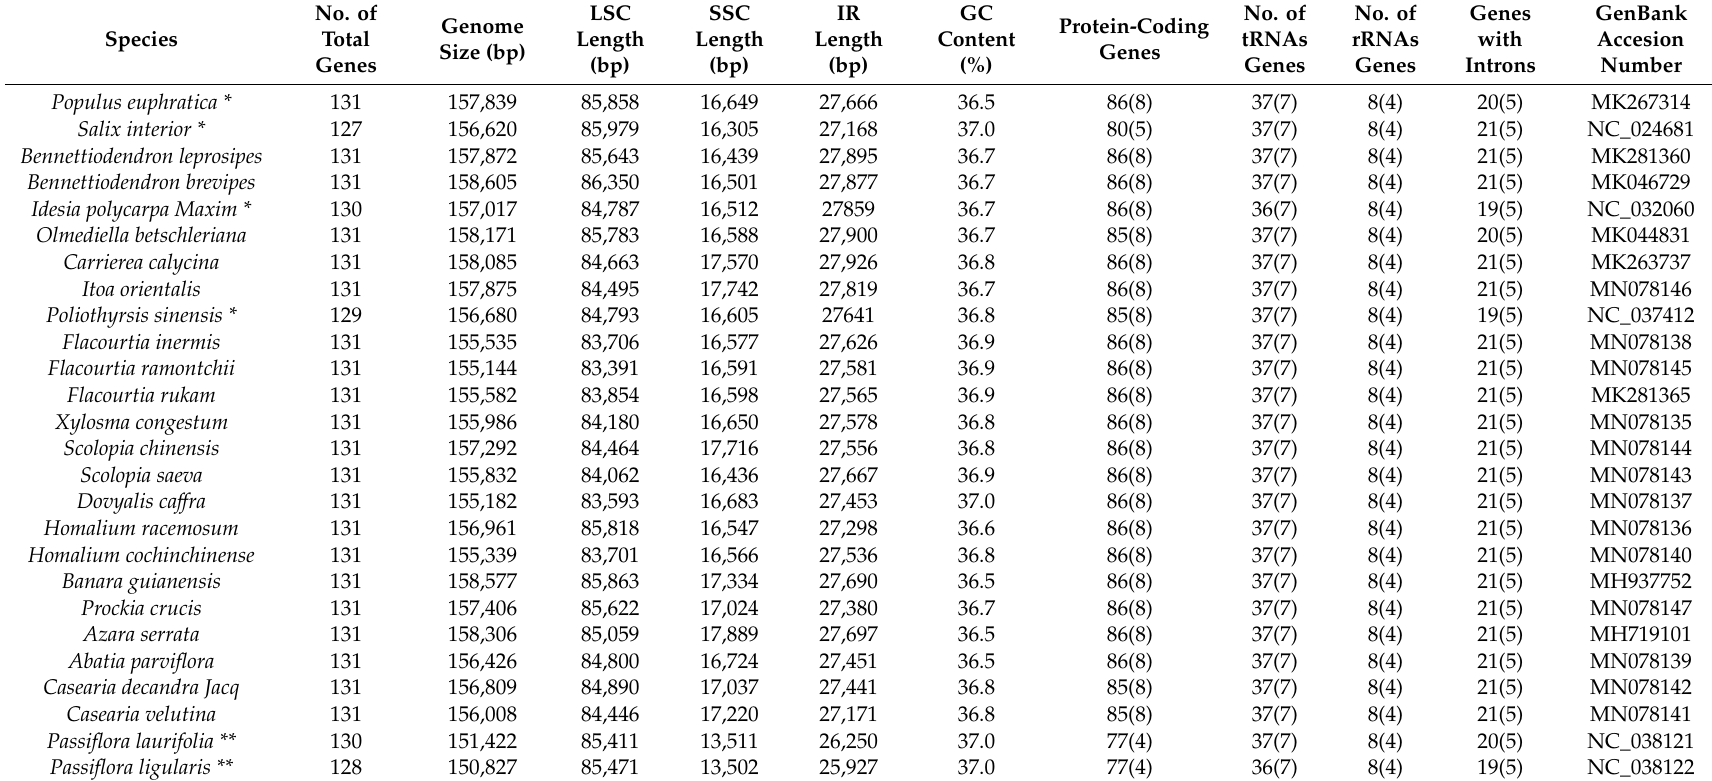
Table 1. Characteristics of plastid genomes of 26